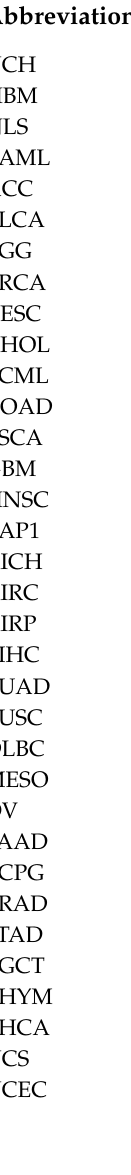
Figure S1: BAP1 variants and stability of multiprotein complexes. Simultaneous view of residue interaction network (left) and 3D structure (in silico analysis) of BAP1-associated protein complexes, such as BAP1-HCF1, BAP1-FOXK2, BAP1-ASXL1, BAP1-BRCA1-BARDI (right). UM-associated mutations are marked (red) for each protein complex, Figure S2: Phosphorylation residues in BAP1 protein are marked (red), Table S1: List of phosphorylation and kinases in BAP1 protein, Table S2: Minimum free energy (mfe) values for BAP1 and